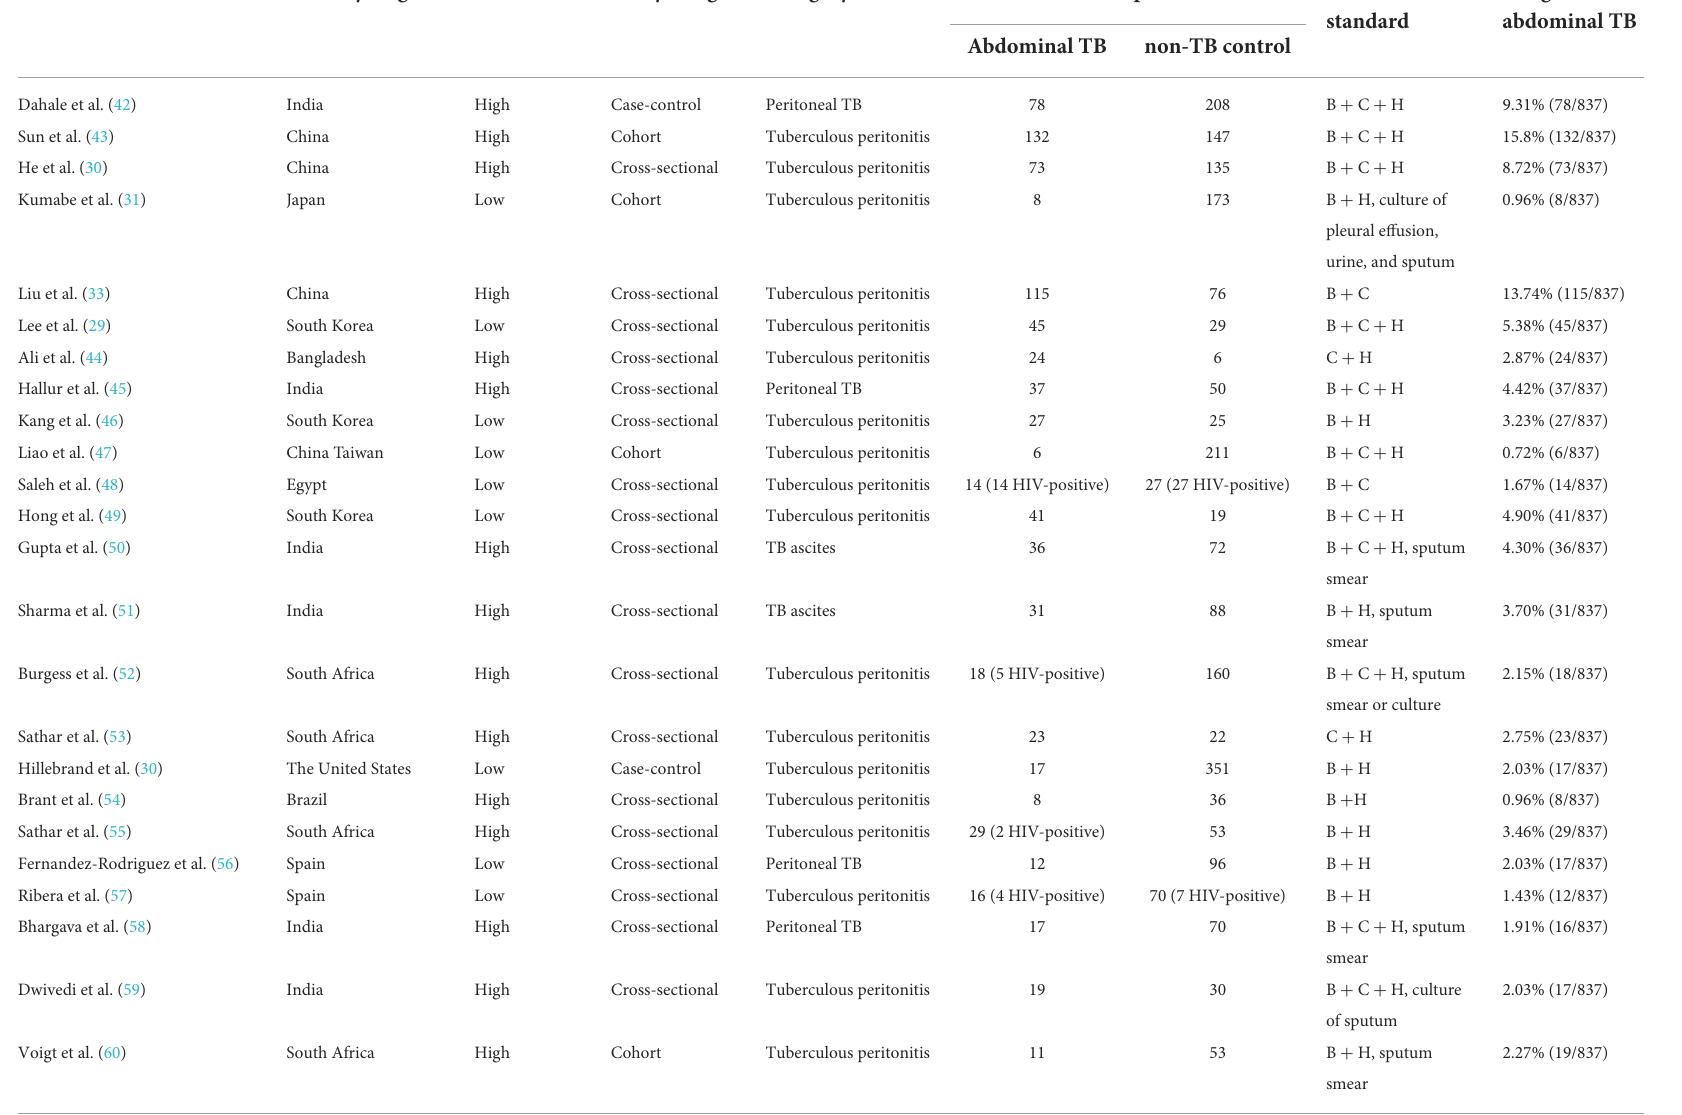
TABLE 1 Main characteristics of included